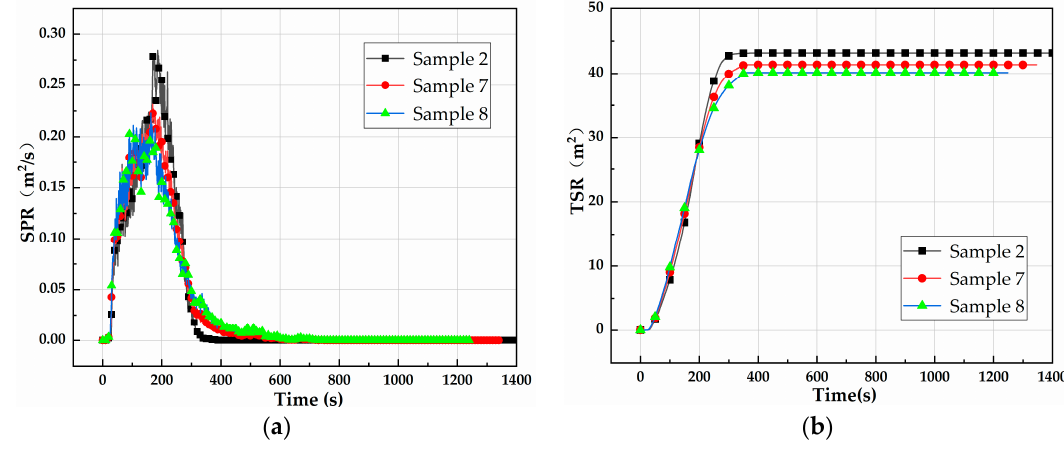
Figure 5. SPR ( a ) and TSR ( b ) curves for asphalt binder.